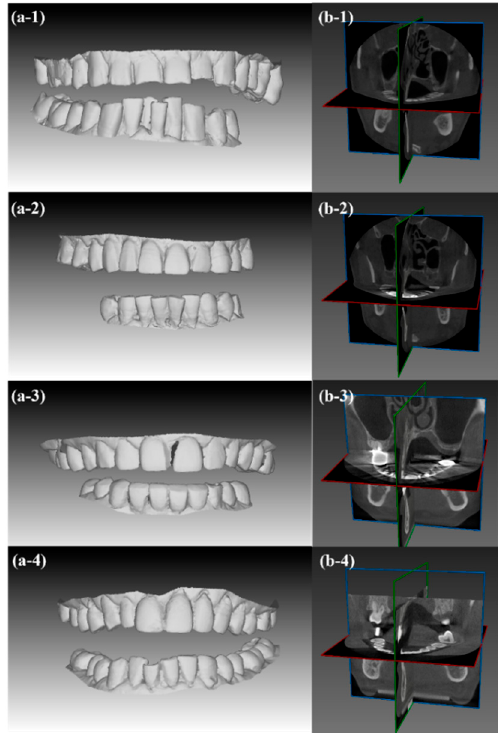
Figure 5. Input data (( a ): surface data, ( b ): volume data). ( 1 ) set no.1 ( 2 ) set no.2 ( 3 ) set no.3 ( 4 ) set no.4.